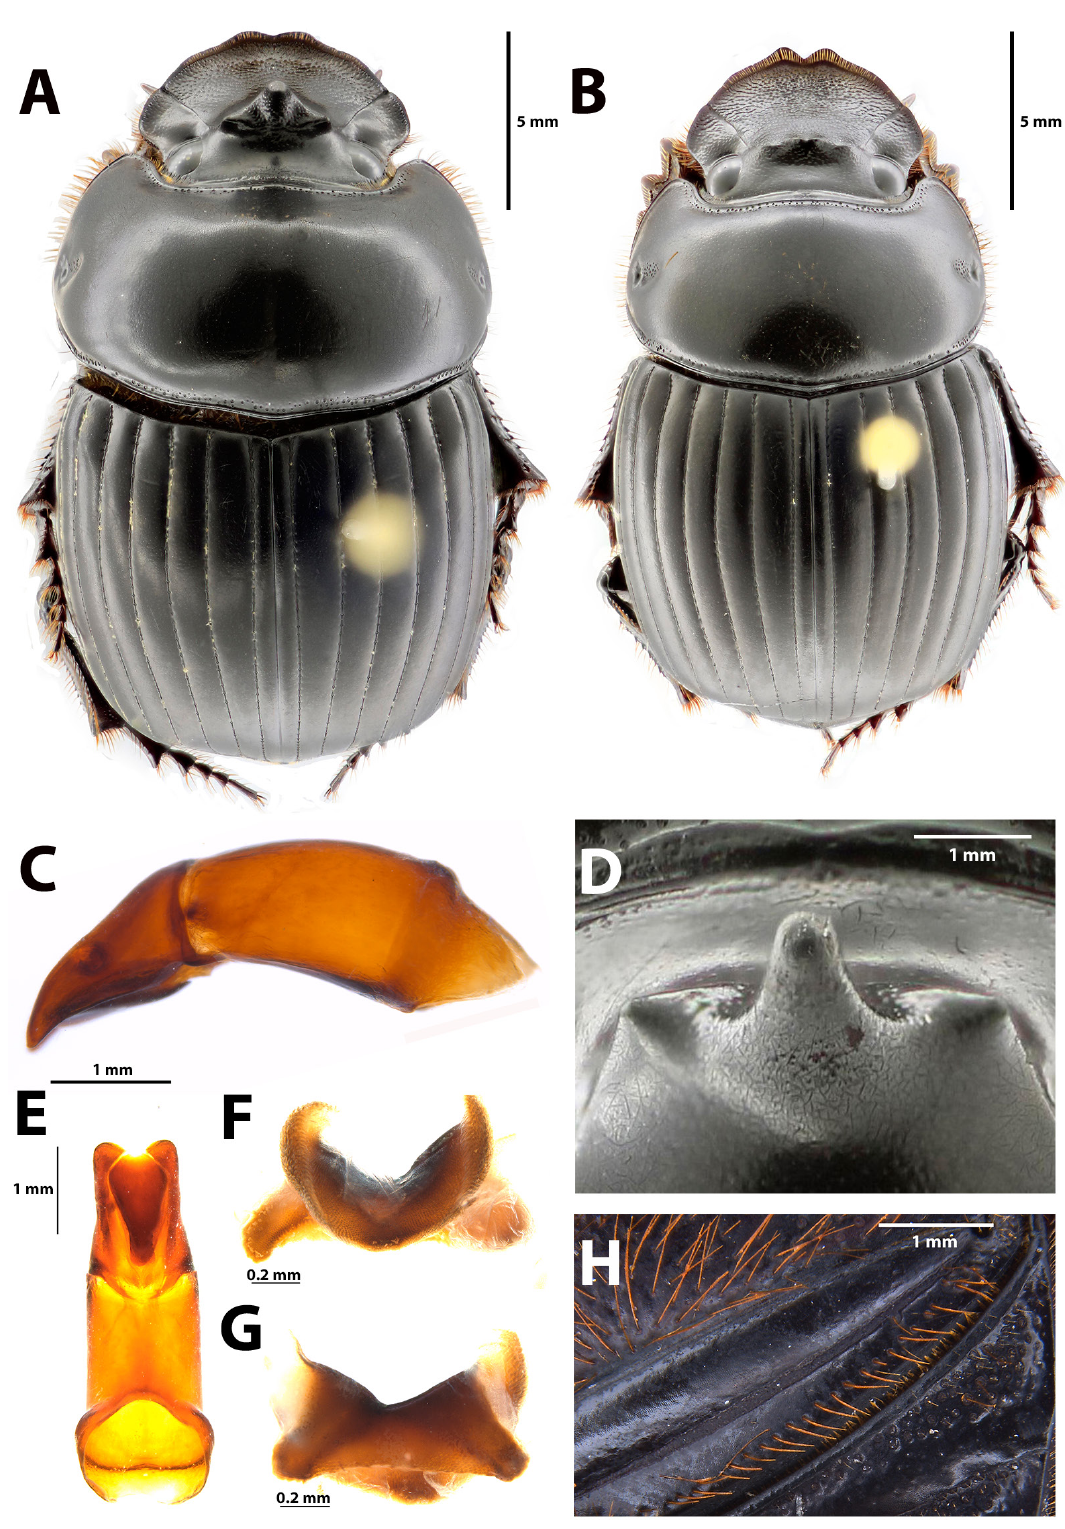
Fig. 13. Dichotomius sagittarius (Harold, 1869) stat. rev. A–B . Dorsal habitus. A . ♂. B . ♀. C . Lateral view of the aedeagus. D . Anterior view of the cephalic carina. E . Ventral view of aedeagus. F–G . Lamella copulatrix. H . Ventral view of the metacoxa, displaying on the posterior margin a single row of organized ocellate setigerous